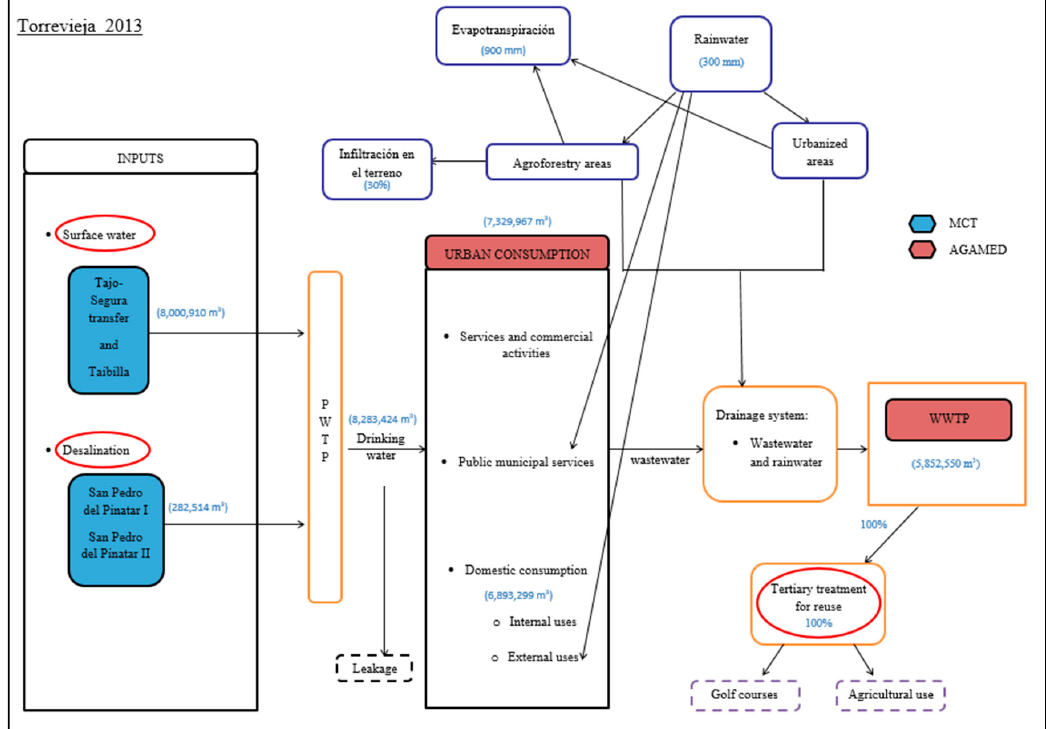
Figure 5. Flow diagram of the city of Torrevieja in 2013. Compiled by the author.